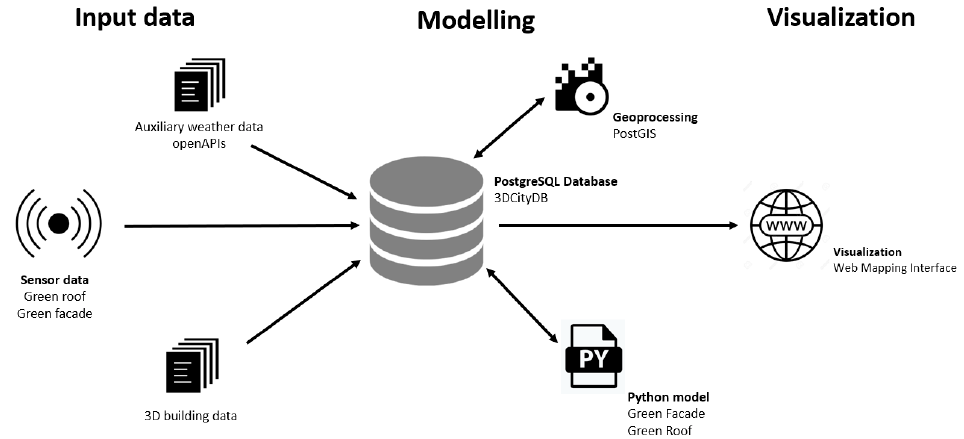
Figure 2. Data modelling and processing infrastructure and workflow.